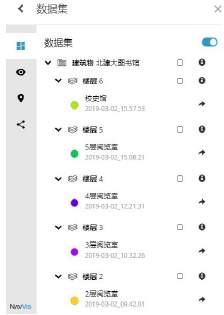
Figure 7. Results of live map release